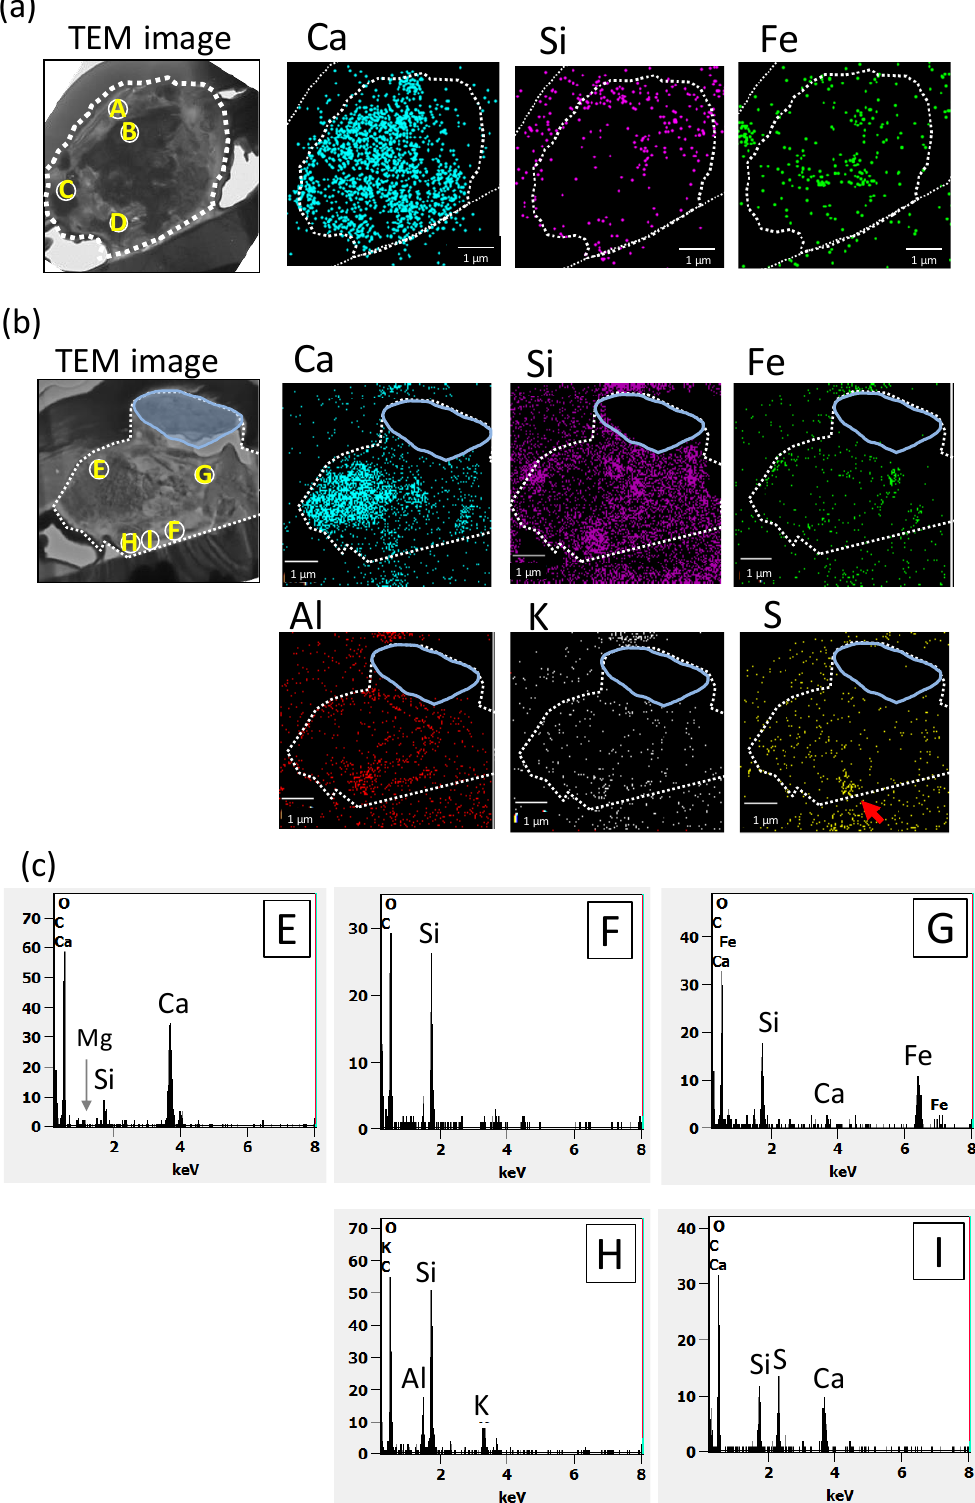
Figure 4. TEM images and EDS element maps of Dust Particles 1 and 2 and EDS spectra: ( a ) Dust Particle 1, ( b ) Dust Particle 2 and ( c ) EDS spectra for spots E–I in Dust particle 2. The maps are X-ray counts after background subtraction. Borders of the particle cross-section are presented as broken white lines. In Dust Particle 2, the region surrounded by a solid light blue line is the portion that was lost before the EDS analysis.